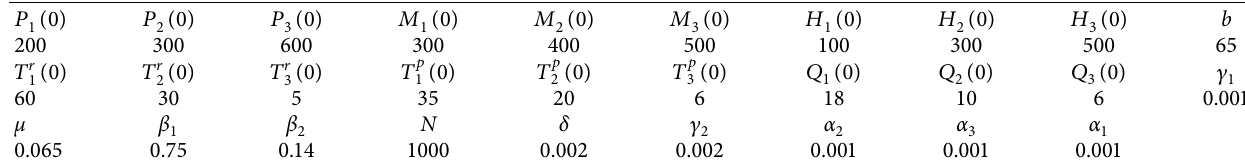
Table 3: The academic parameters used for model